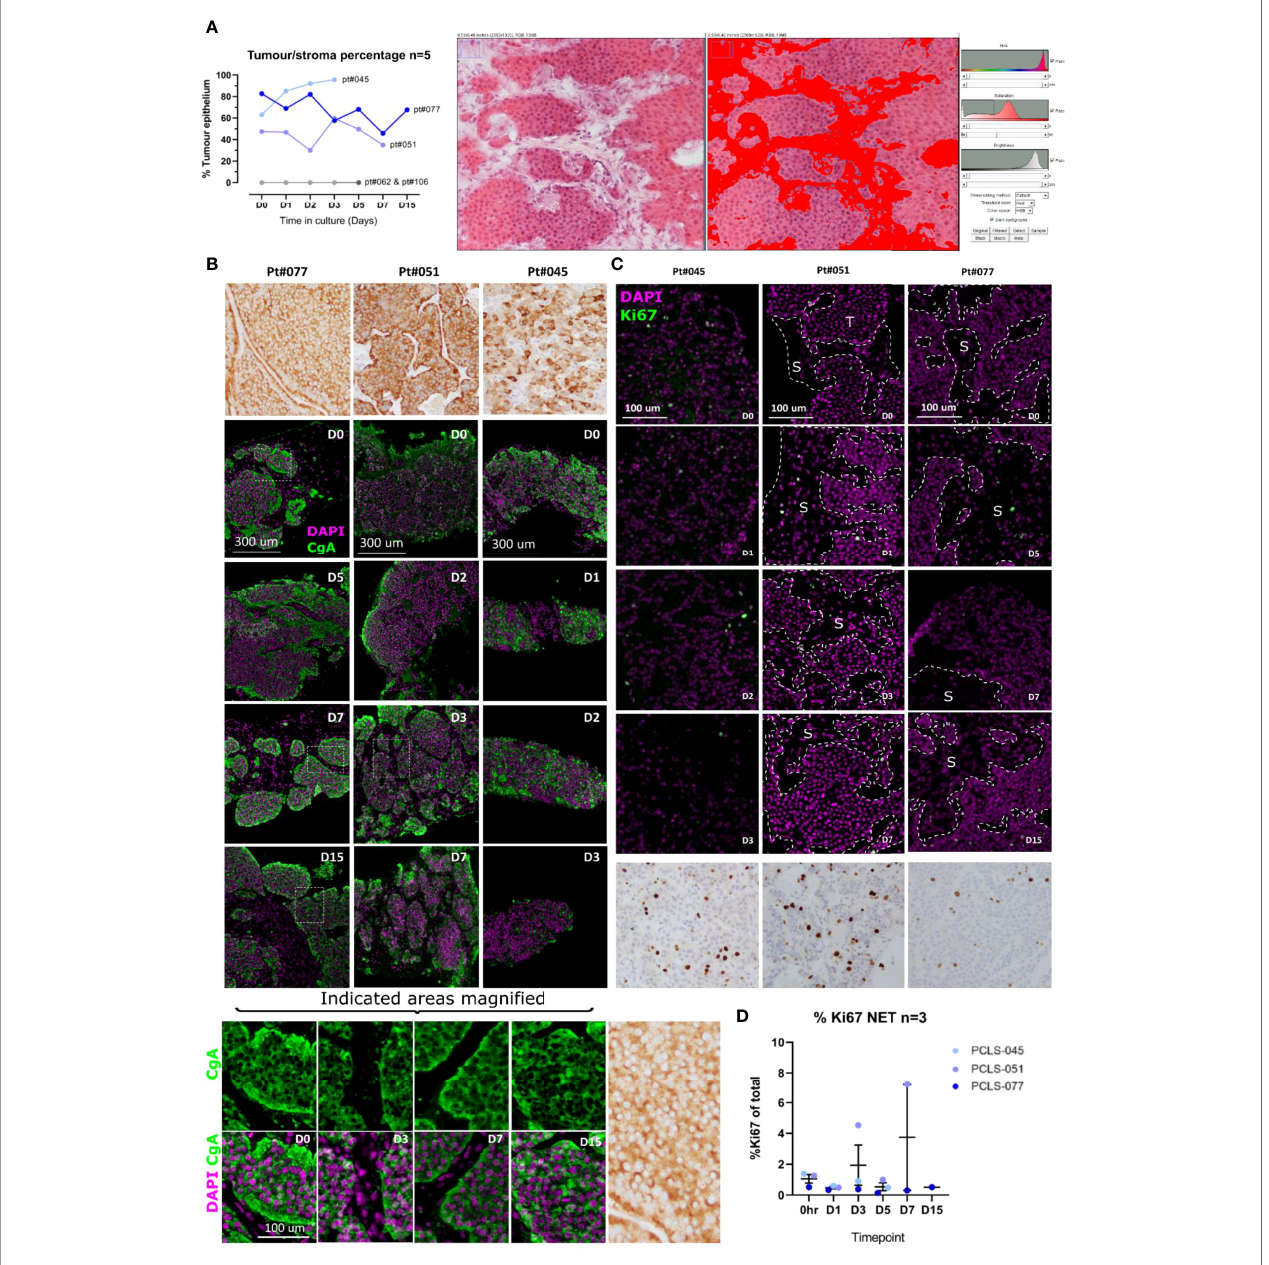
FIGURE 4 | LM-NEN PCTS retain key molecular features associated with tumour grade and neuroendocrine differentiation. (A) The areas of tumour epithelium and stroma (highlighted in red) were measured in the H&E images of each patient throughout the culture using ImageJ as indicated on the right panel (n patients =5) and the epithelium percentage is shown for each patient per timepoint. Patients 062 & 106 lacked tumour epithelium hence % = 0. (B) Chromogranin A (CgA) staining in brown or green and DAPI (purple) on epithelial LM-NEN tissue slices at indicated timepoints. (C) Representative images for Ki67 staining (positive nuclei in green or brown) and DAPI (in purple) at indicated timepoints. Areas of tumour and stroma are indicated with T and S, respectively. Images in (B, C) at D0-D7 are representative of 3 technical replicates per patient, for D15, 1 replicate. (D) Ki67 was quanti fi ed in 3 images per patient and presented as %Ki67 of total number of cells per image. Data are shown as mean ± SD of 3 patients and each dot represents a single